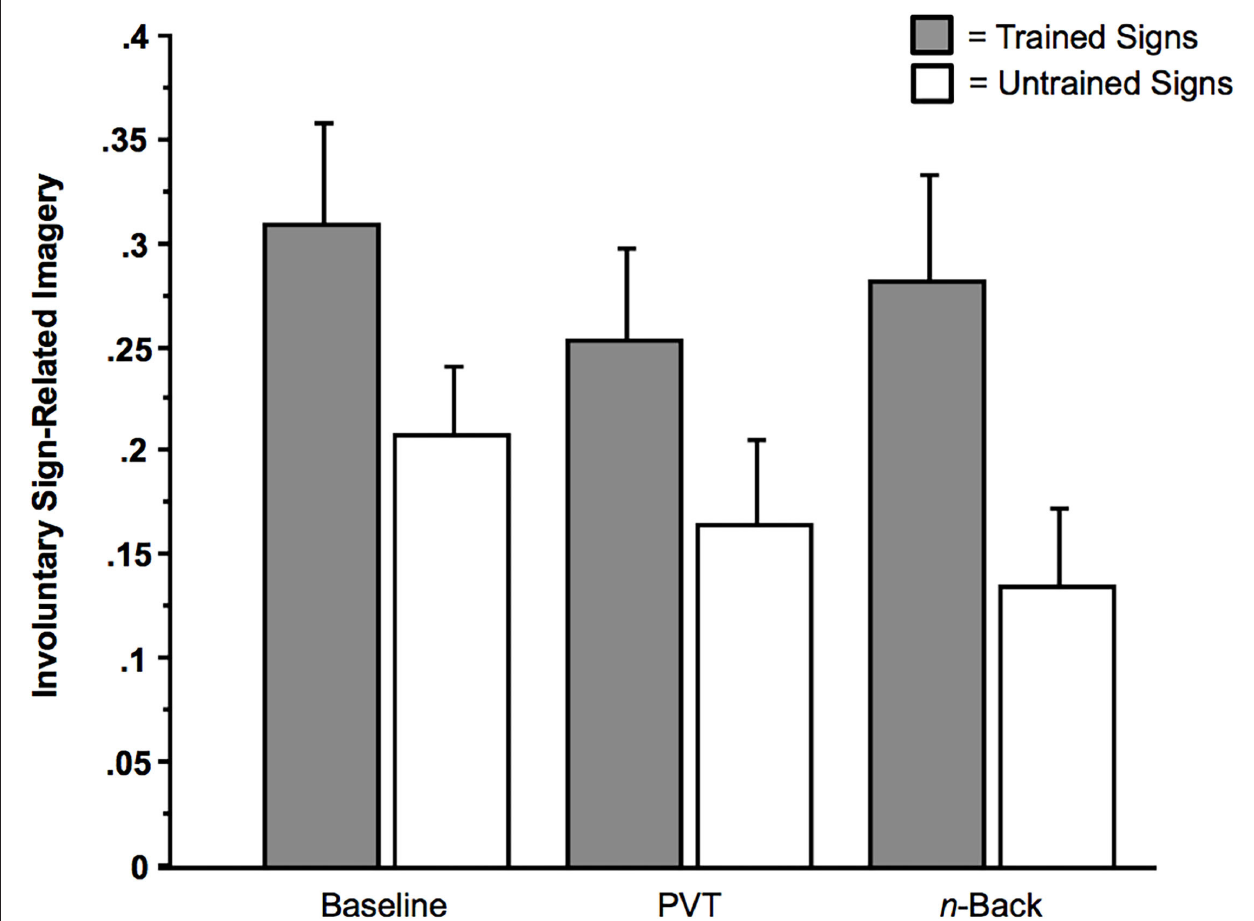
FIGURE 5 | Sign-related involuntary imagery as a function of Sign Type (Trained vs. Untrained [Control]) and Multi-Tasking (None [Baseline], Psychomotor Vigilance Task [PVT], or n -back). Error bars indicate SE s.